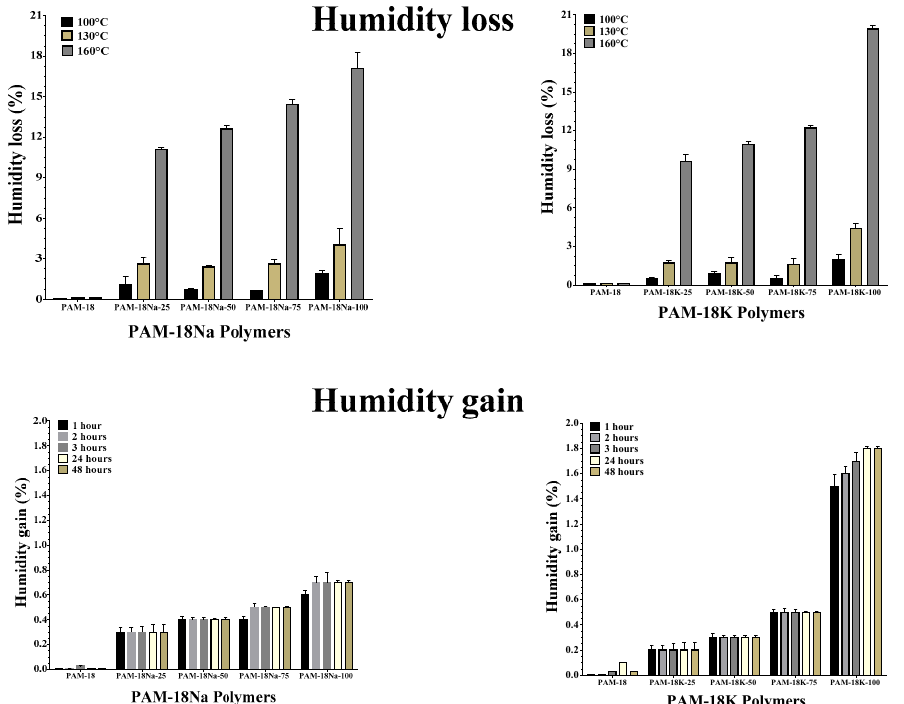
Figure 7. Loss and gain of humidity by the PAM-18Na and PAM-18K polymers.